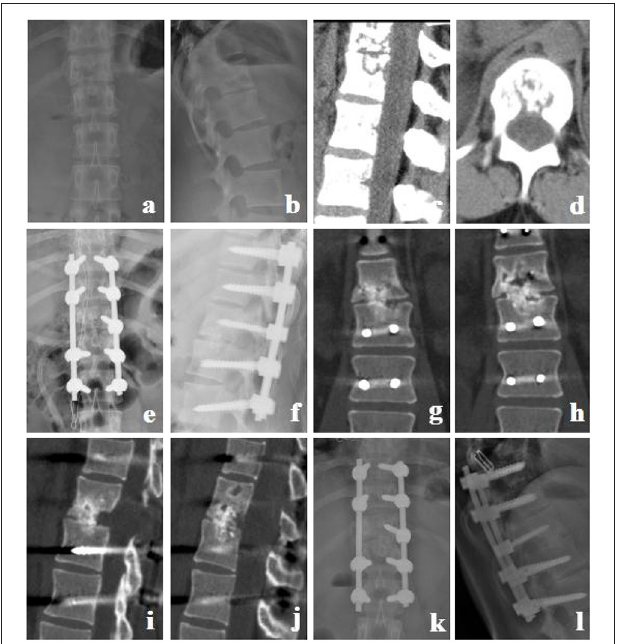
FIGURE 1 | Granular bone graft group. A 22-year-old female with T12-L1TB received a granular bone graft for reconstruction. (a–d) Preoperative X-ray and CT showed that the T12 and L1 vertebral bodies and the intervertebral disc were destroyed, and thoracolumbar instability was formed. (e,f) Postoperative X-ray. (g–j) CT at 5 months postoperative showed bone fusion between T12 and L1. (k,l) X-ray at 12 months postoperative showed good location of posterior instrument and normal thoracolumbar curve.